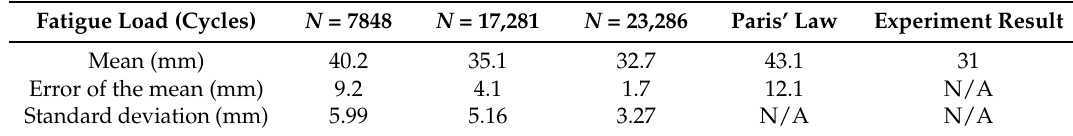
Table 4. The prognostic crack length of the specimen T 5 for N = 26,620 cycles.